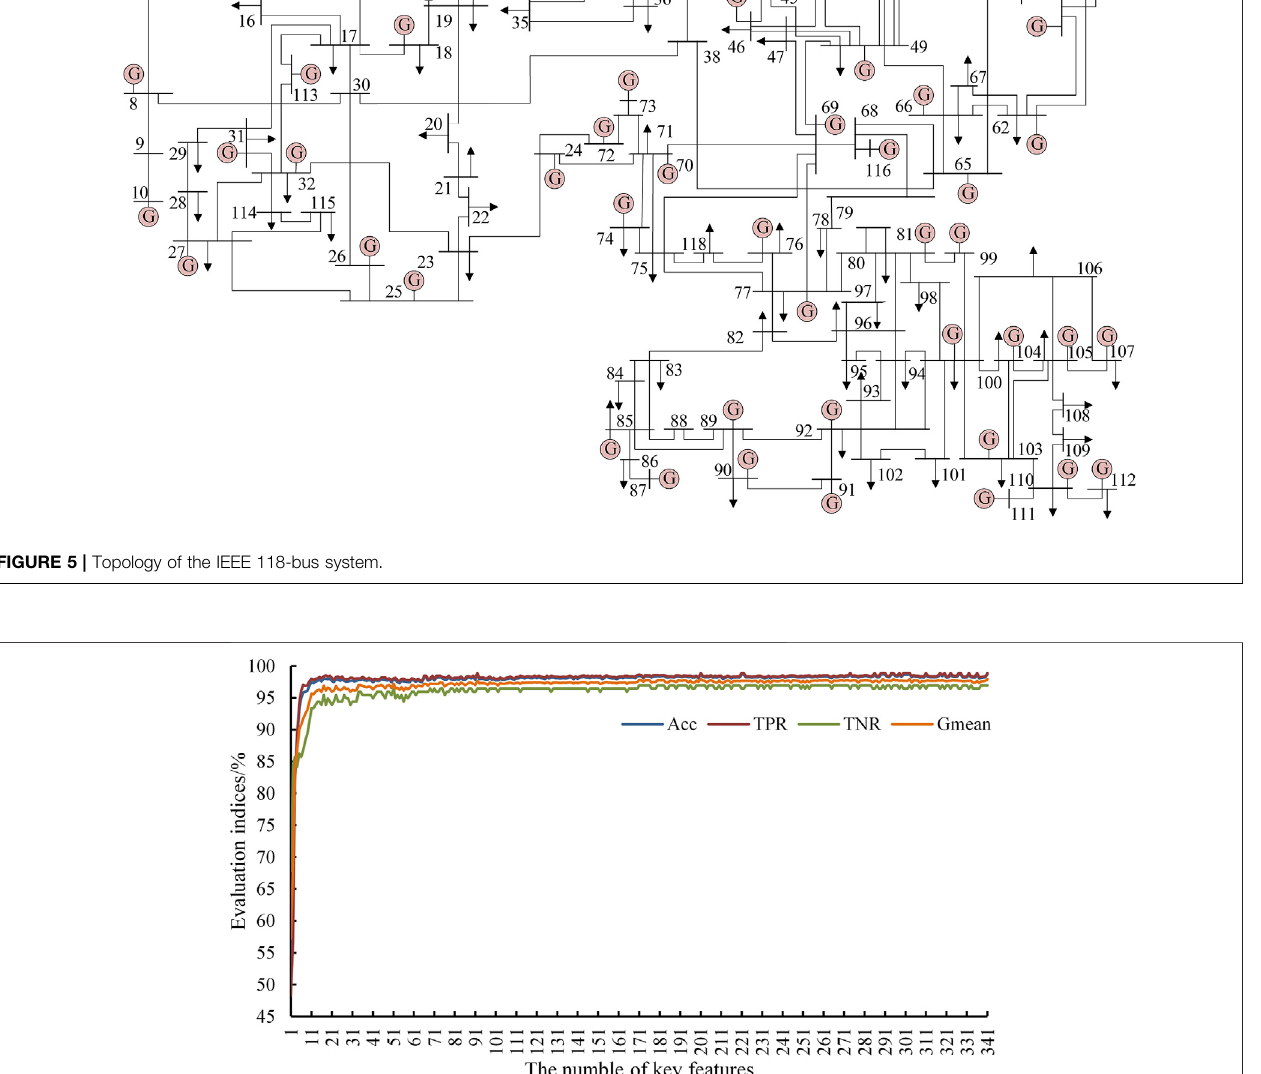
Frontiers in Energy Research |